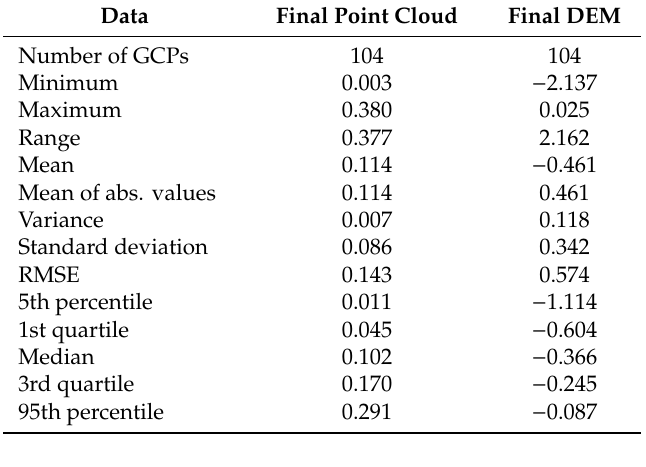
Table1. Summarystatisticsofcloud-to-cloud3DdistancesbetweentheGCPsandthefinalTLS-UAV-SfM point cloud and of the elevation di ff erences between the GCPs and the final DEM (units in meters).